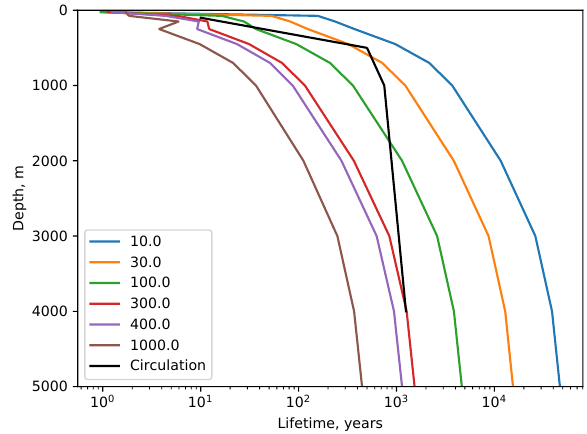
Figure 6. Global model fluxes as a function of Hg(II) sinking ve- locity imposed in the model. Colors represent preanthropogenic and present-day results from our model. For comparison broken lines are model results from Zhang et al. (2014a) and Semeniuk and Das- toor (2017), sediment trap data from Mason et al. (2012), 17 ◦ N latitude in the Pacific and 60m water depth, extrapolated globally. A default value of 500myr − 1 is the base case for the rest of the simulations in this paper.